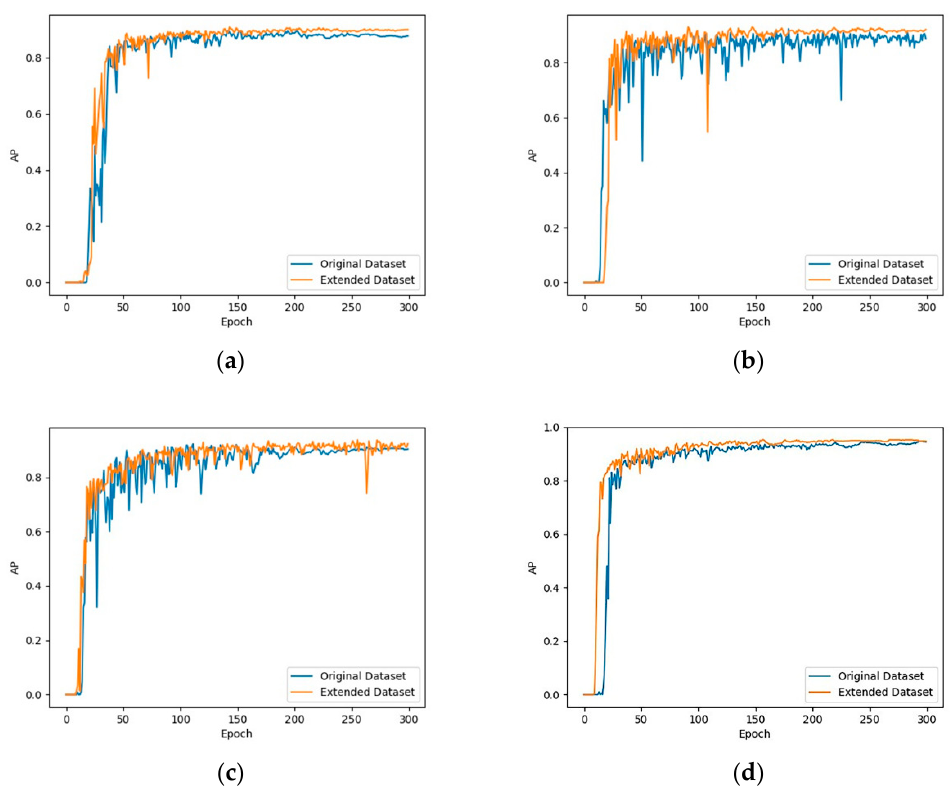
Figure 19. AP curve for original dataset and extended dataset: ( a ) SSD; ( b ) Faster R-CNN; ( c ) original YOLOv3; ( d ) improved YOLOv3.